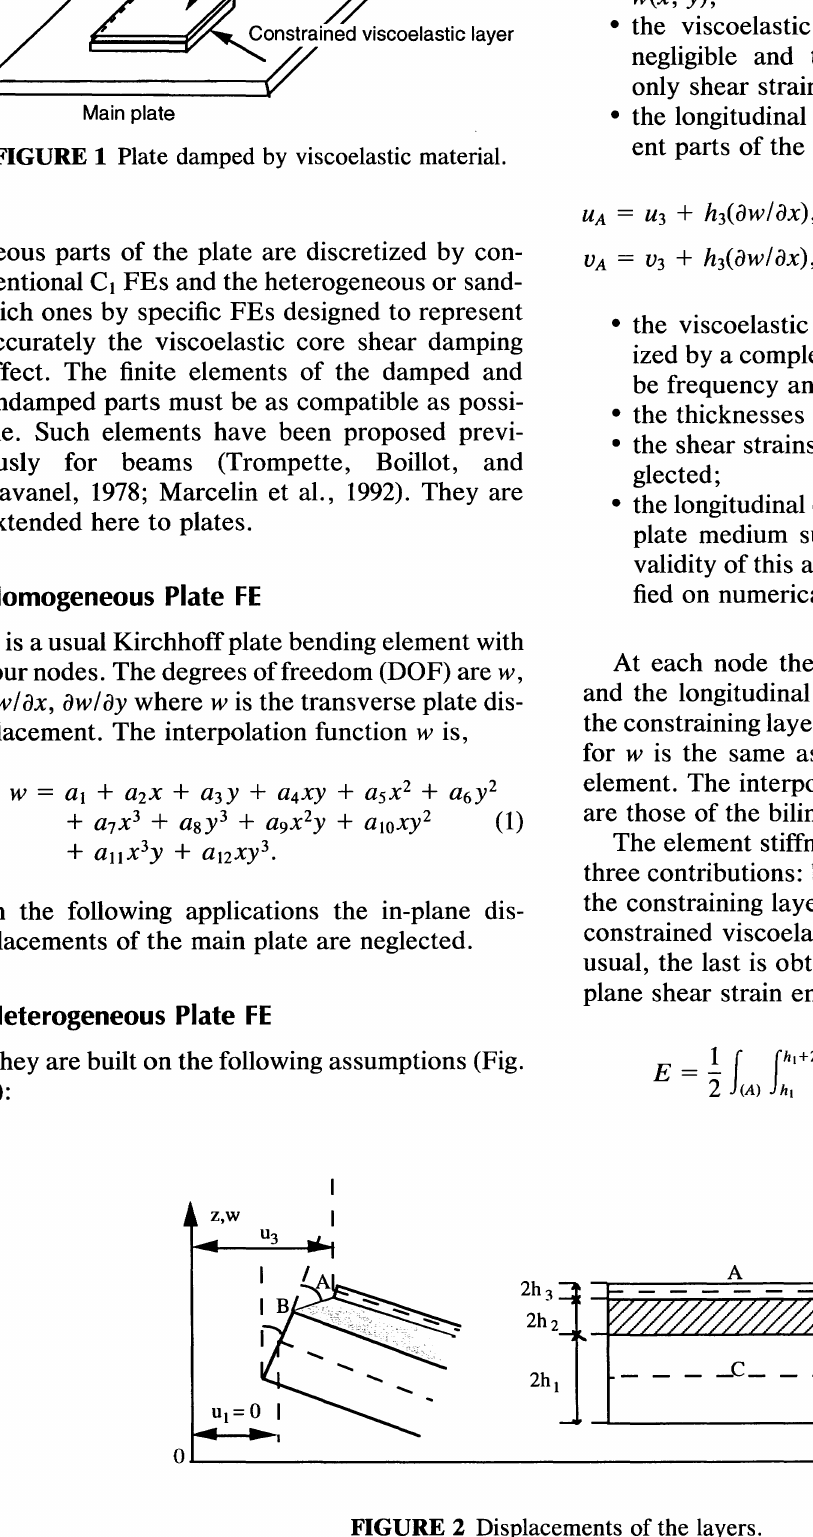
FIGURE 1 Plate damped by viscoelastic material.